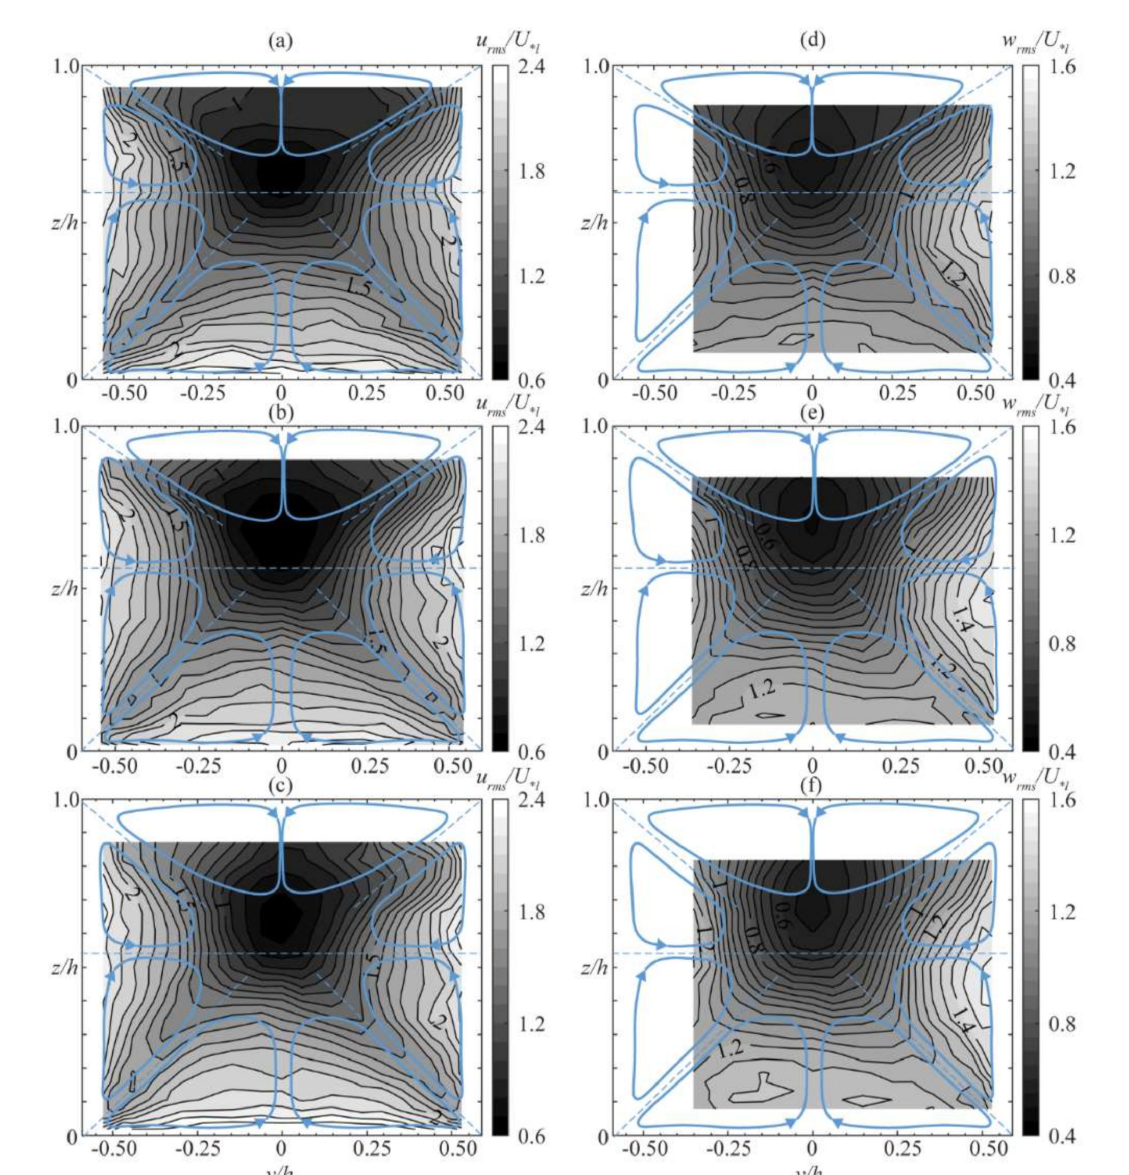
Figure 7. Contour plots of turbulence intensities in ( a – c ) streamwise direction, ( d – f ) vertical direction for